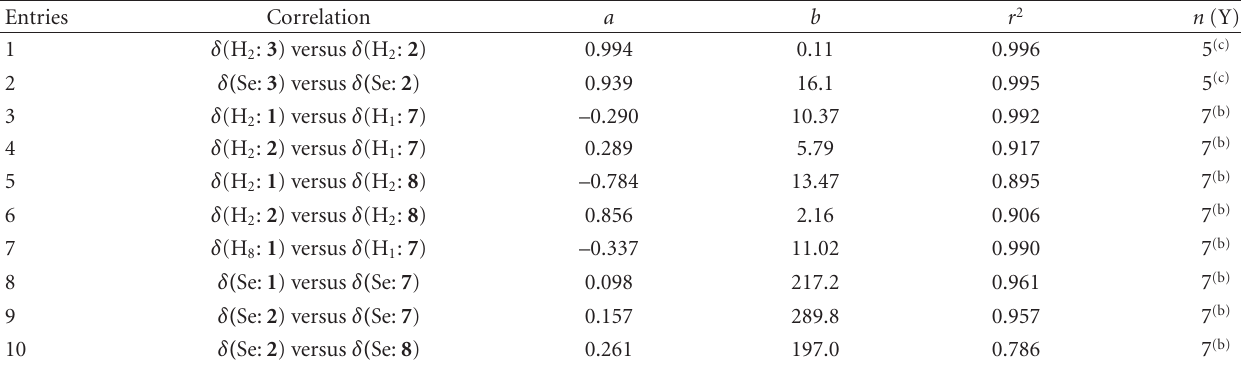
Table 3: Correlations of δ (H) and δ (Se) in 1 − 3 , 7 , and 8 in solutions (a)